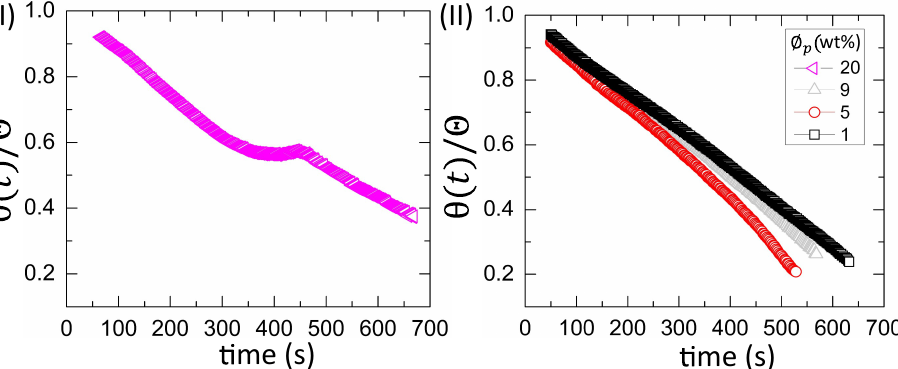
Figure 9. Time evolution of the normalized contact angle ( θ ( t ) / Θ ) in the BSA droplets at the different initial concentrations ( φ p ) of 20 wt% in ( I ) and from 9 to 1 wt% in ( II ) for T = 25 ◦